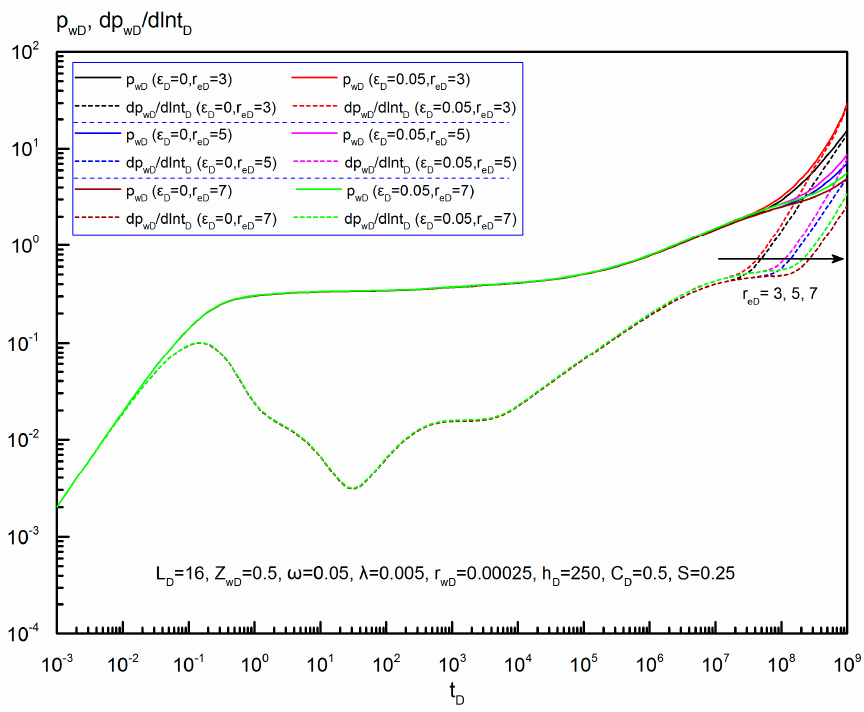
r ) on a horizontal well’s transient pressure